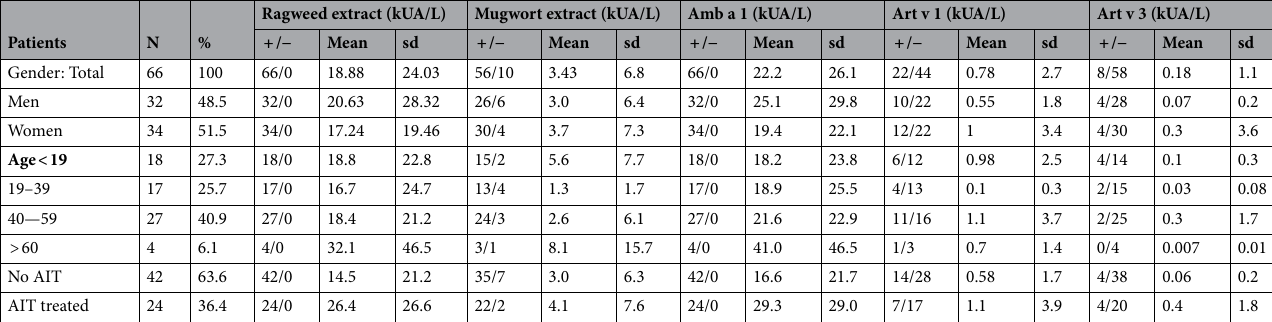
Table 1. Specific IgE to ragweed and mugwort extracts, to Amb a 1, Art v 1, and Art v 3 components of 66 participants enrolled in the study.